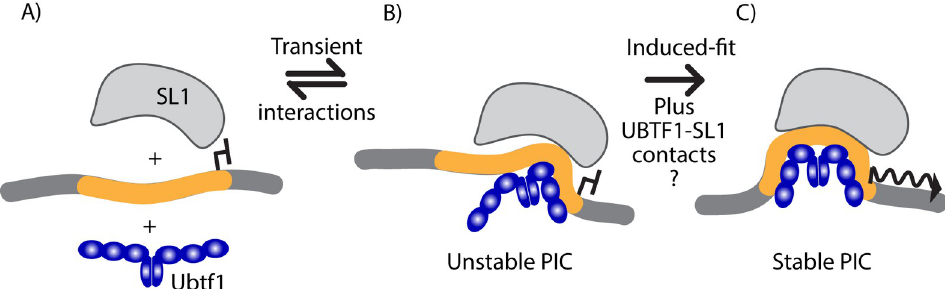
UBTF1 binding induces a transient reshaping of the promoter that allows SL1 to form weak DNA interactions. C) Tightening of UBTF contacts induces further promoter reshaping inducing a new DNA surface that closely “fits” the DNA interaction surface of SL1. The promoter and flanking DNA sequences are shown respectively in orange and dark grey, the region of UBTF known to bend DNA is shown in blue, SL1 in light grey, and the active transcription initiation site is indicated by an